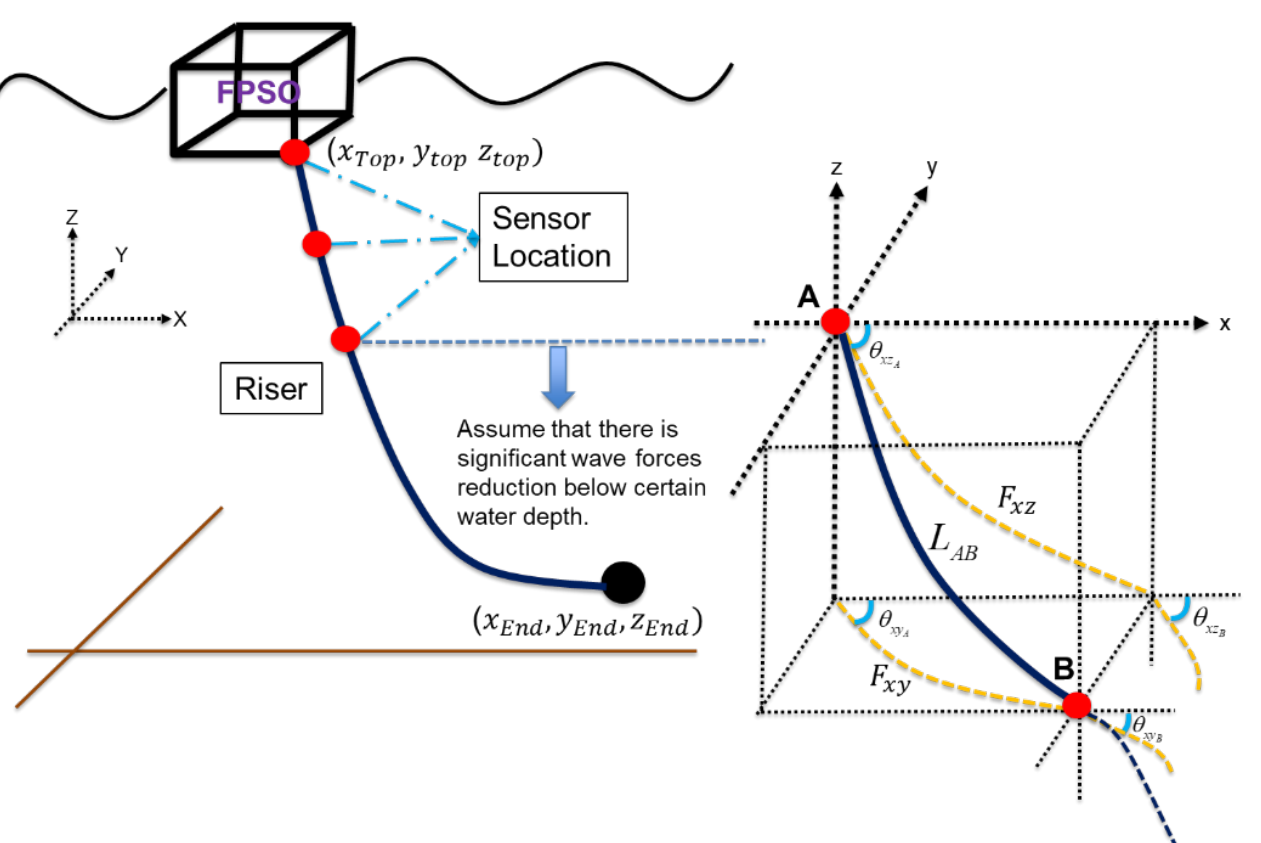
Figure 2. Configuration for Node Displacements and Discretized Bending Moment Tracing.